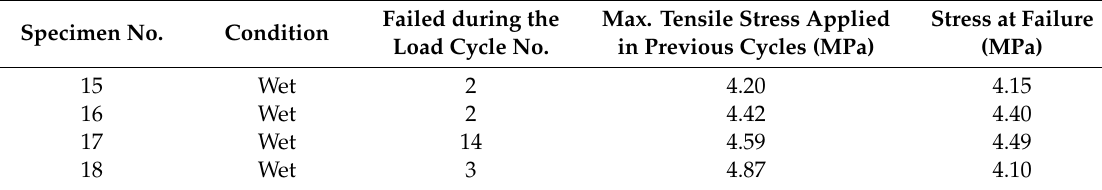
Table 5. Cyclic load results for specimens 15 to 18.